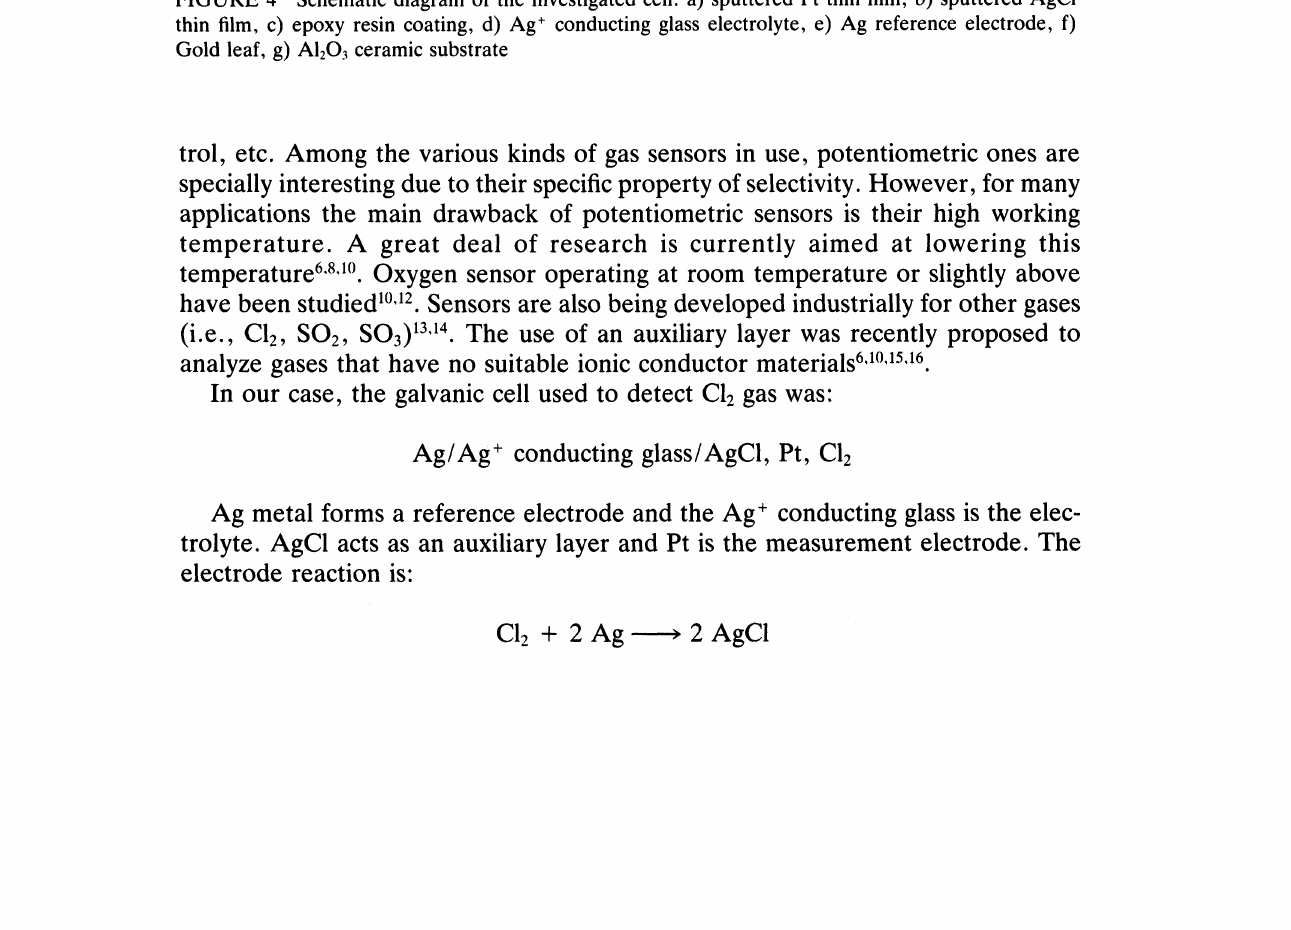
FIGURE 4 Schematic diagram of the investigated cell: a) sputtered Pt thin film, b) sputtered AgCI thin film, c) epoxy resin coating, d) Ag conducting glass electrolyte, e) Ag reference electrode, f) Gold leaf, g) A1203 ceramic